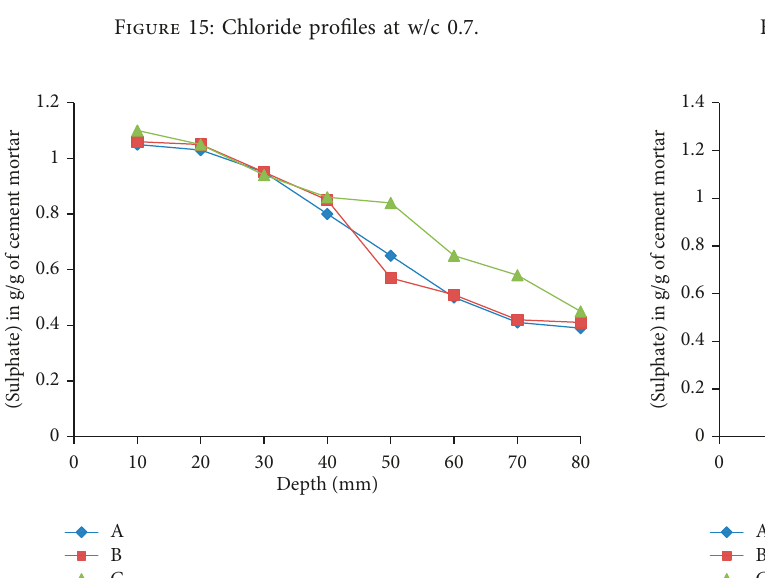
Figure 16: Sulphate profiles at w/c 0.5.